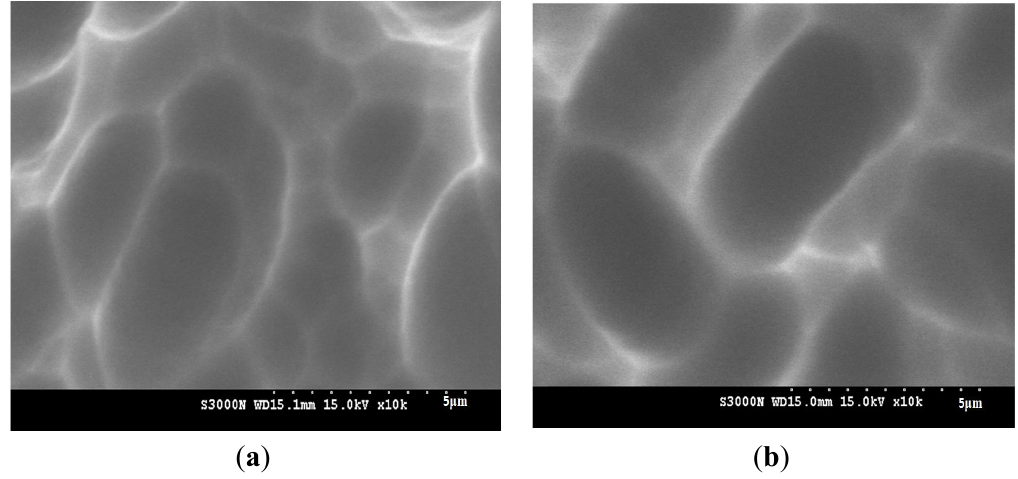
Figure 3. SEM surface micrographs of the silicon solar cell samples: ( a ) the control sample without polymer coating; and ( b ) the polymer-coated sample using 1% reactive mesogen precursor solution.